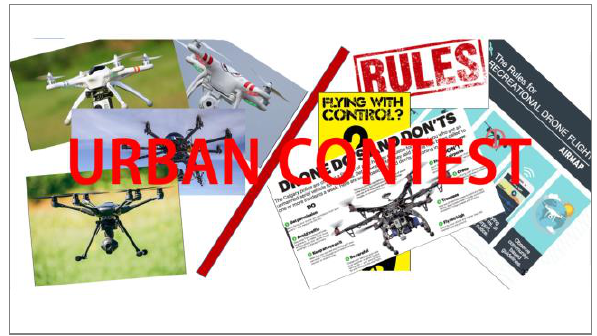
Figure 1. UAV and rules for flight in urban